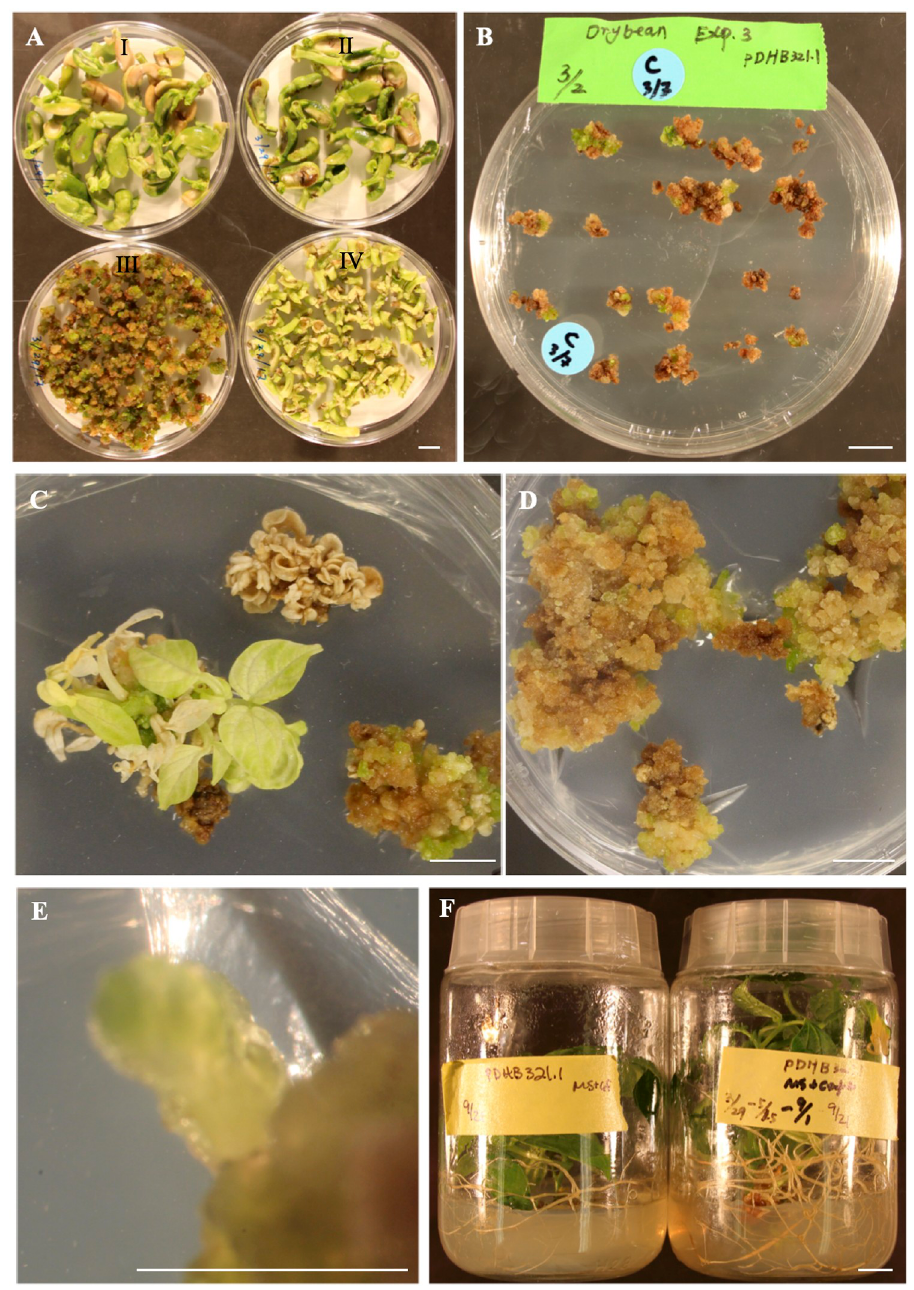
Fig 3. A . tumefaciens -mediated transformation of ‘Olathe’ pinto bean. (A) Explants after 4-day co-cultivation in the dark at 25 ˚C. (I, II) Half-seeds explants. (III) Precultured embryo axes explants. (IV) Embryo axes explants. (B) Precultured embryo axes explants after 3-week selection on selection RM1. (C) Embryo axes explants after 6-week selection on selection RM3. (D, E) GS-resistant calli and green buds induced from the precultured embryo axes explants after 6-week selection on selection RM3. (F) Rooting of the GS-resistant plants produced from the precultured embryo axes explants. Bars = 1 cm.